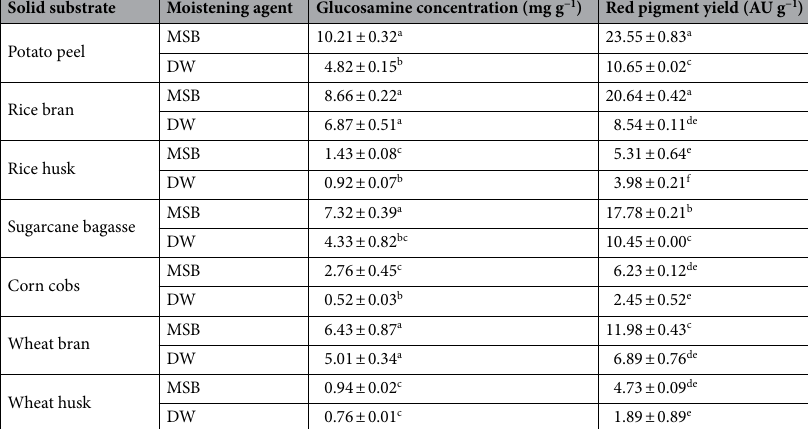
Table 1. Fungal growth (mg glucosamine g −1 dry fermented substrate) and red pigment yield (AU g −1